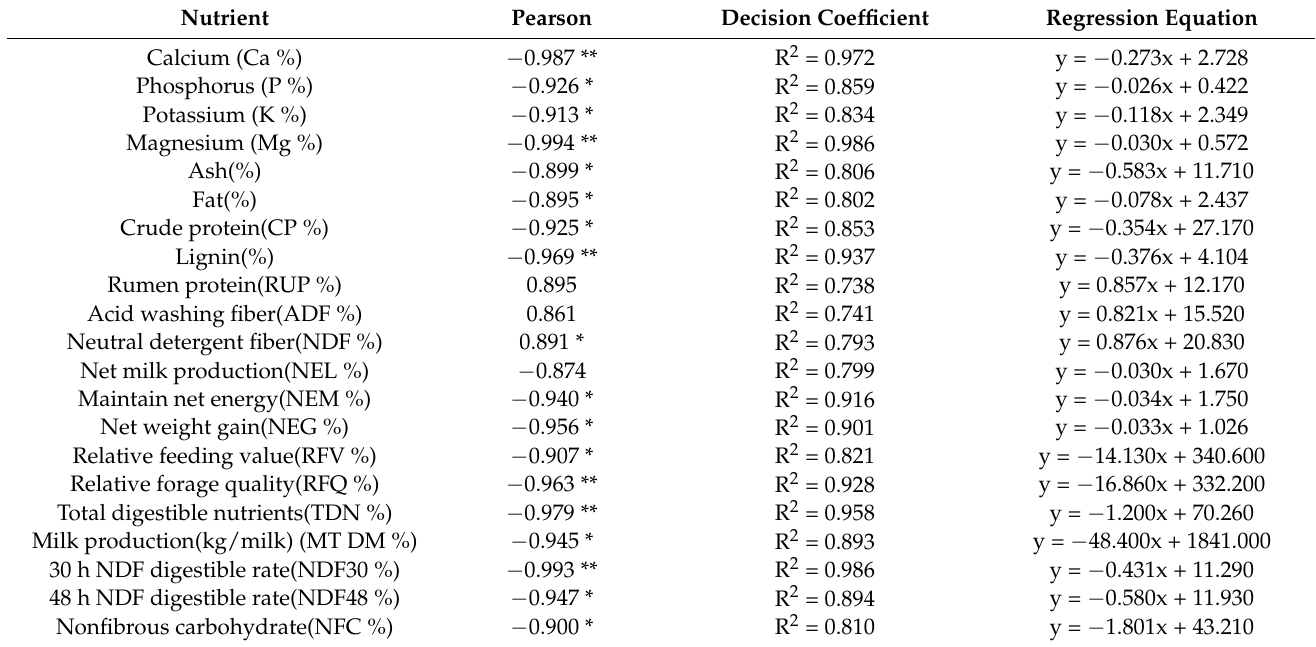
Table 6. Correlation between the severity of alfalfa Leptosphaerulina leaf spot and alfalfa leaf nutri- ent